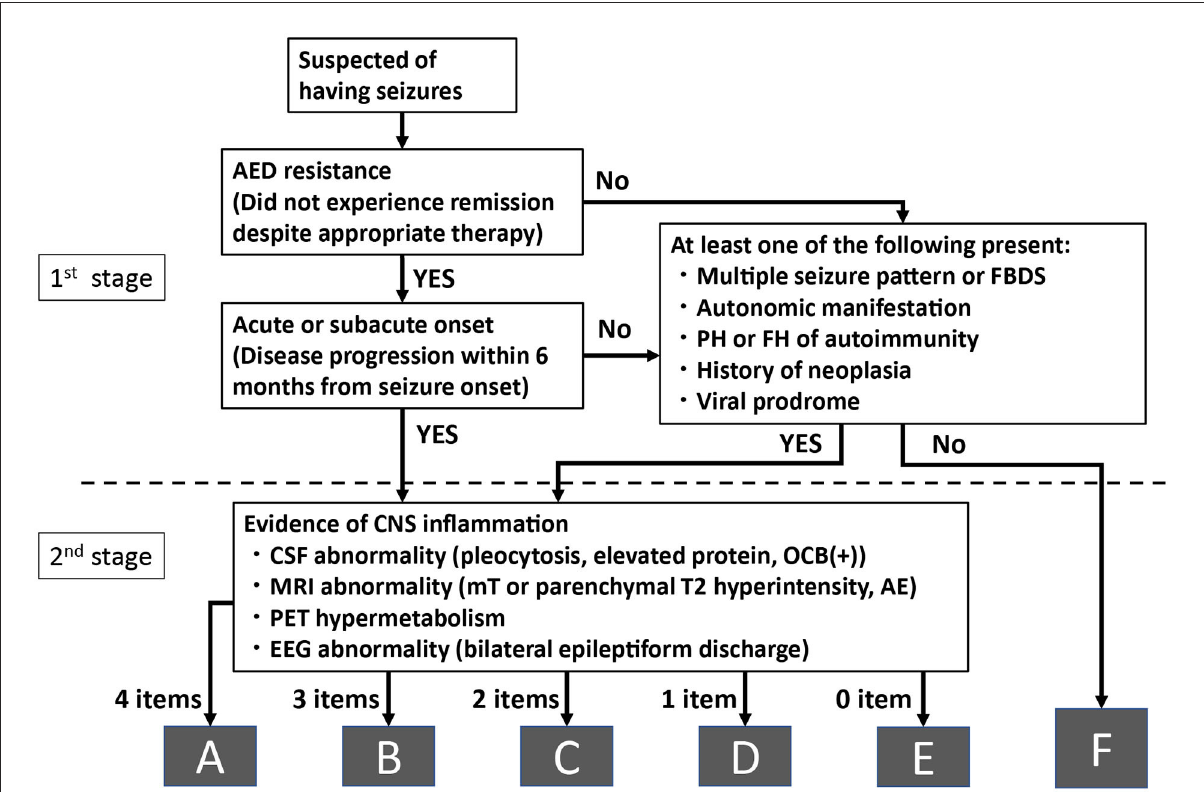
FIGURE1 Algorithm for diagnosing autoimmune epilepsy without evaluating antineuronal antibodies. AE, amygdala enlargement; AED, antiepileptic drugs; CNS, central nervous system; CSF, cerebrospinal fluid; EEG, electroencephalography; FBDS, faciobrachial dystonic seizure; FH, family history; MRI, magnetic resonance imaging; mT, medial temporal; OCB, oligoclonal bands; PET, positron emission tomography; PH, past